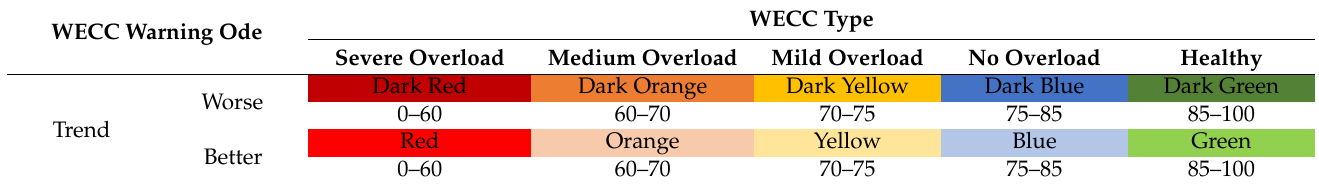
Table 2. WECC trend status and index